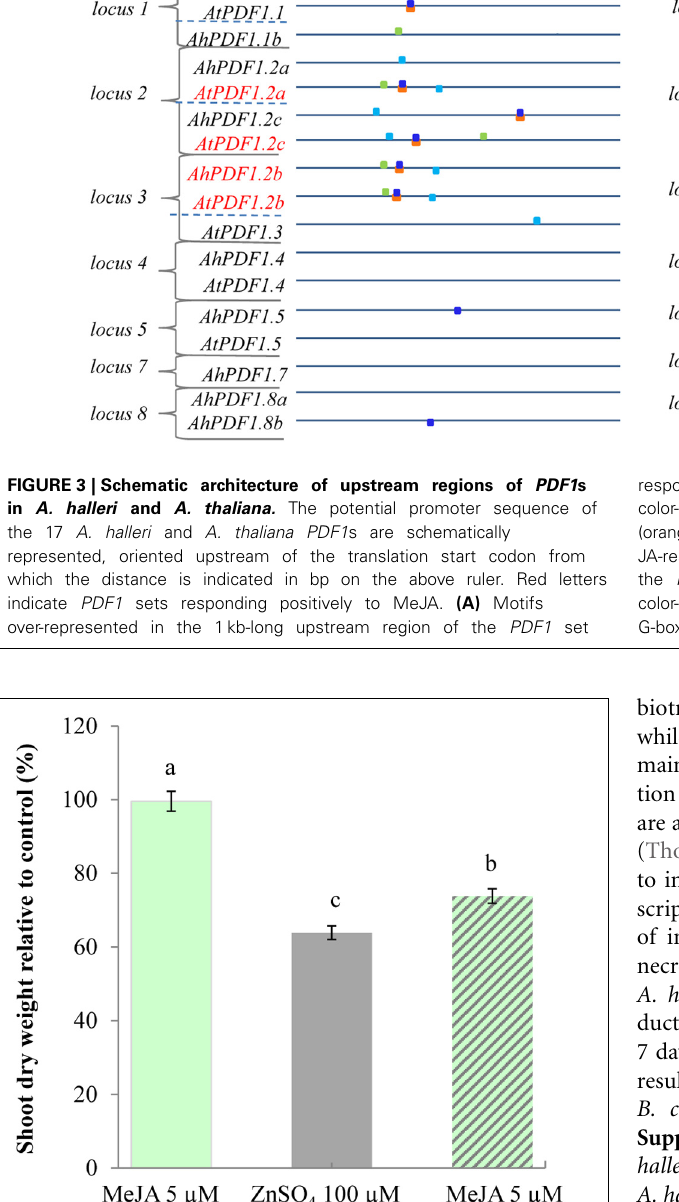
FIGURE 4 | Increased zinc tolerance of A. thaliana upon exposure to MeJA. Shoots of A. thaliana seedlings were collected from plants ( n = 20) 9 days following germination in control conditions or in the presence of 5 µ M MeJA (light green) or 100 µ M ZnSO 4 (gray), or both 5 µ M MeJA and 100 µ M ZnSO 4 (hashed). For each condition, shoot dry weights are standardized to the shoot dry weight of seedlings germinated in control conditions. Different letters indicate significant differences ( P < 0 . 05) according to the Kruskal–Wallis